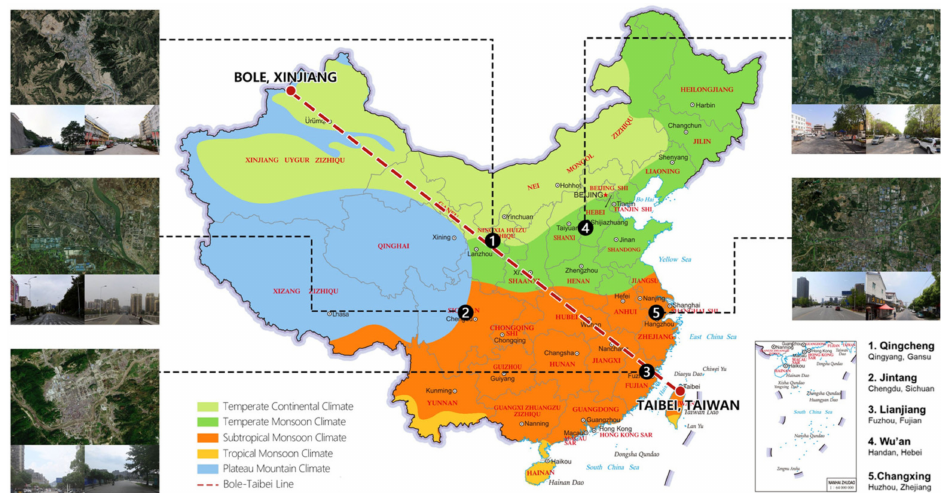
Figure 2. Location of observation